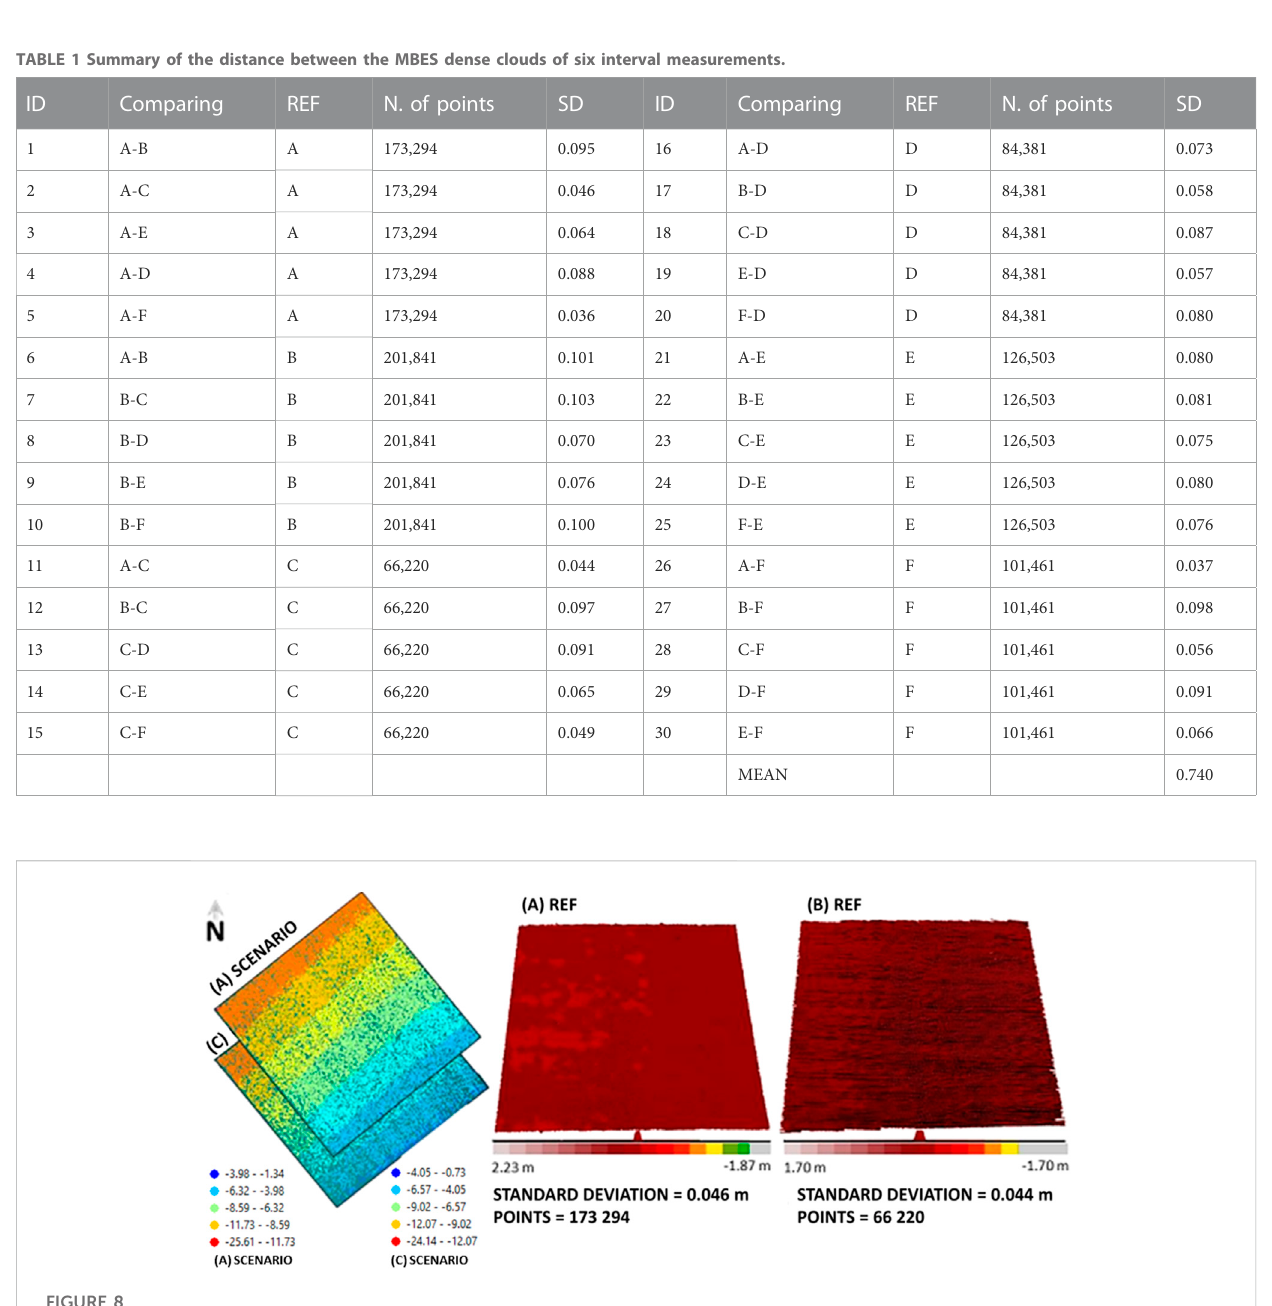
FIGURE 8 Example of dense cloud comparison using M3C2 tool (A) speed 1.5 knots direction NE - SW; (B) speed 1.5 knots direction SE - NW; (C) speed 4.5 knots direction NE -